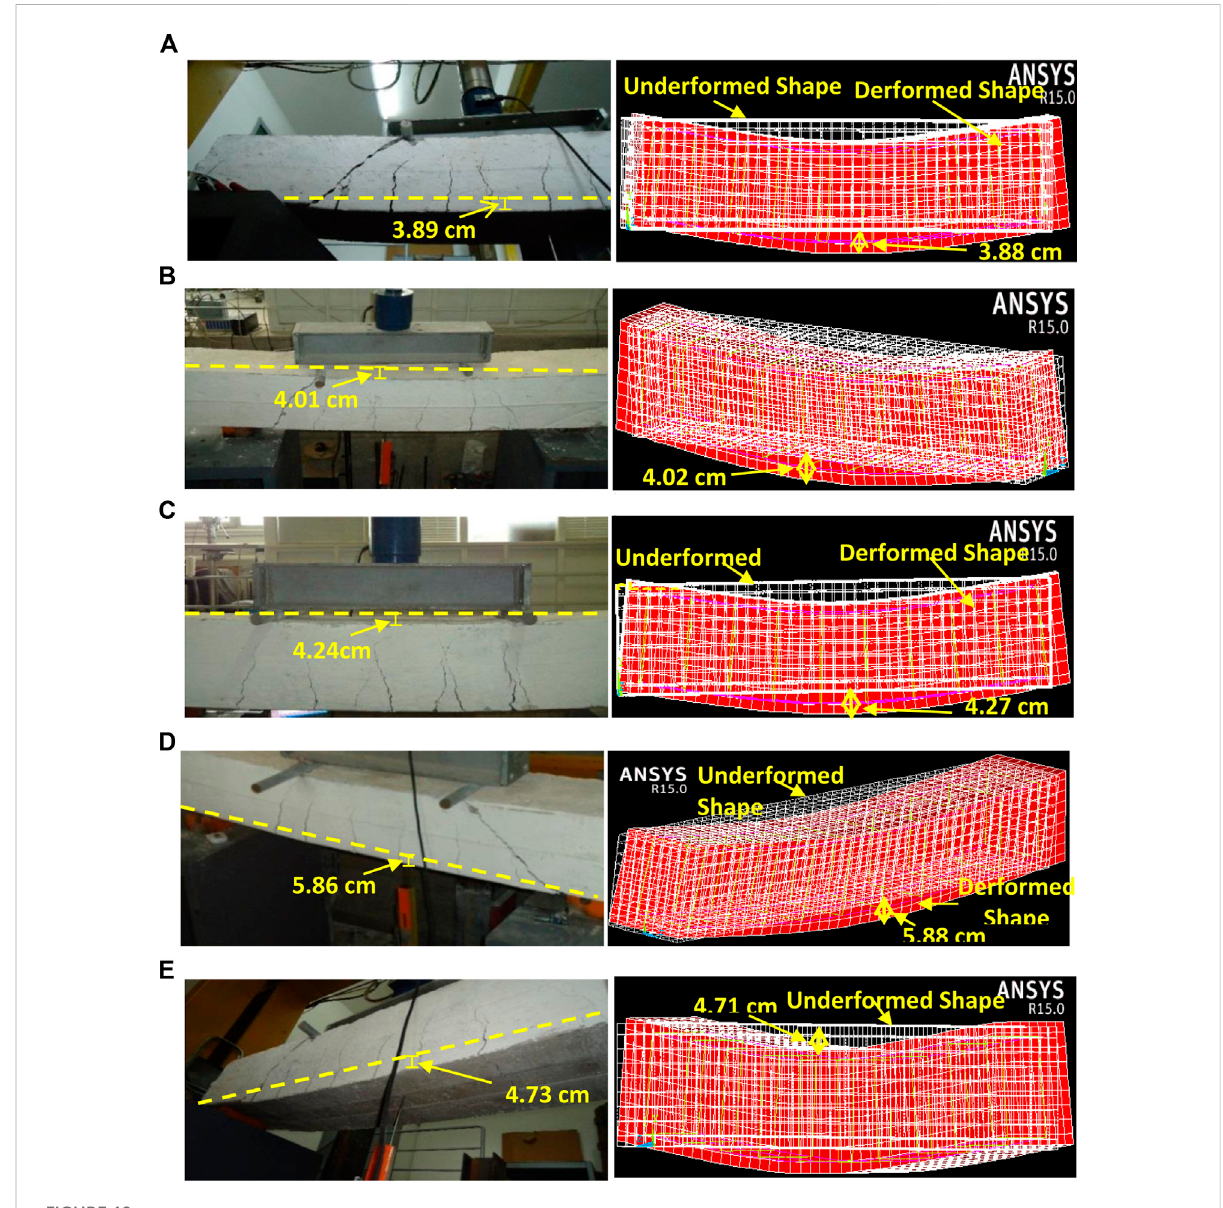
FIGURE 19 De fl ectioneffectsweredeterminedusingRCBexperimentaltestsand3Dnumericalanalysis,showingdifferentresultsforreferencetests (A – E) .